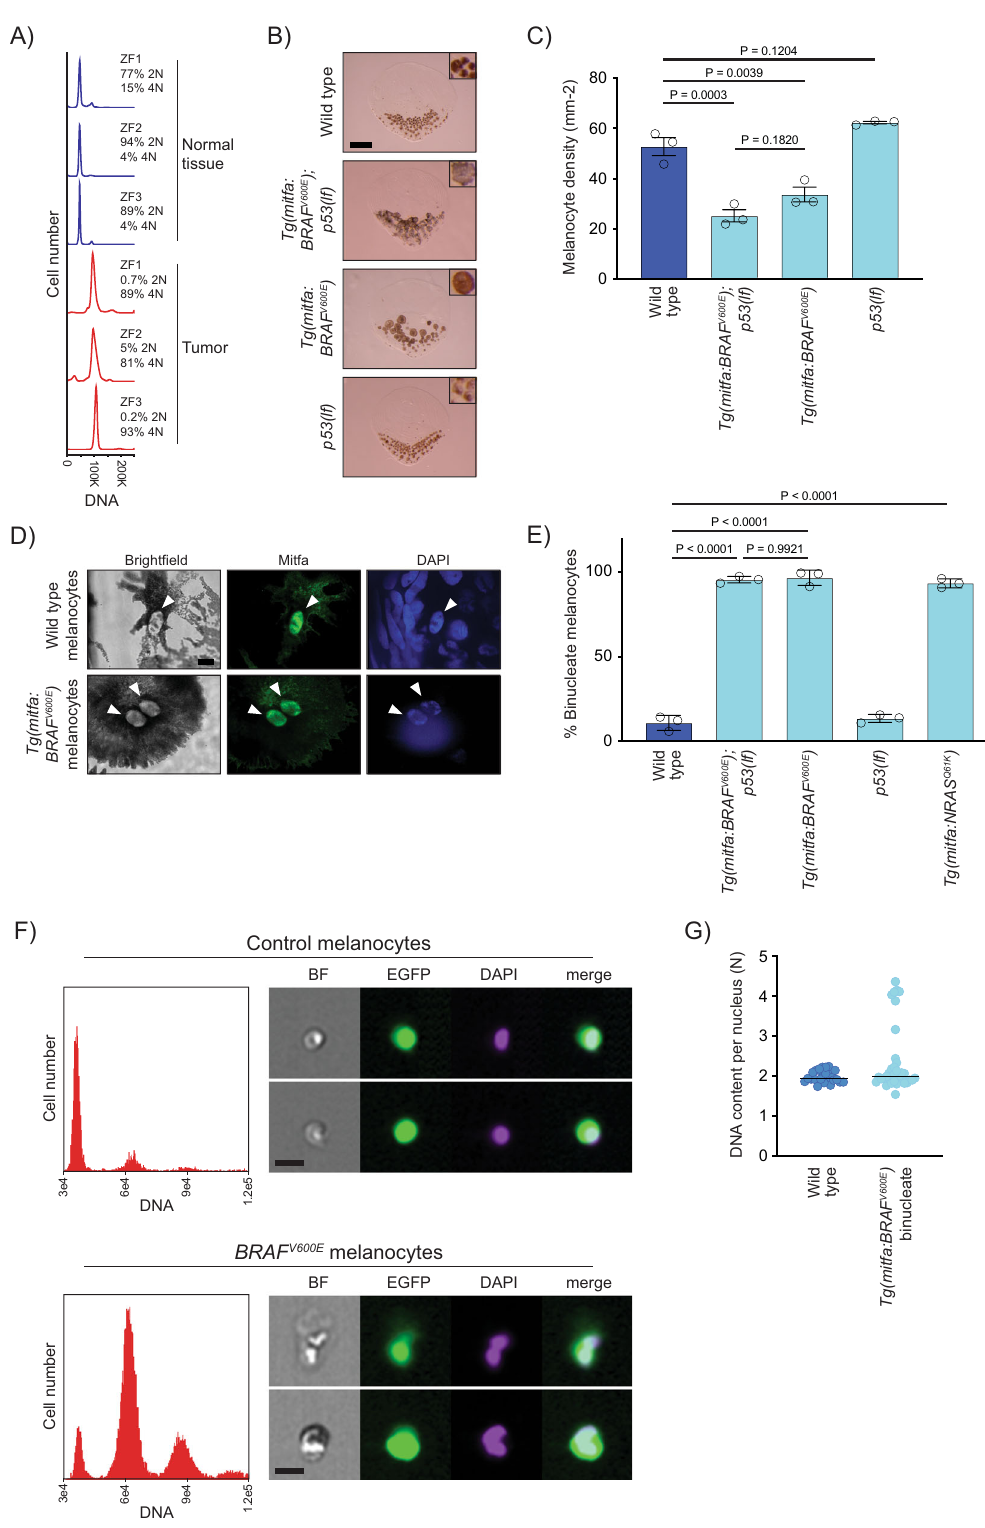
reliably identi fi ed by GFP-positivity and characterized without melanin spectral interference. Flow cytometry showed that Tg(mitfa:BRAF V600E ) melanocytes were predominantly tetraploid, with small fractions of diploid and octoploid cells observed (Fig. 1F). Flow cytometry also con fi rmed the binucleate nature of these cells (Supplementary Fig. 1D). DNA densitometry of fi xed samples found that most nuclei in binucleate Tg(mitfa:BRAF V600E